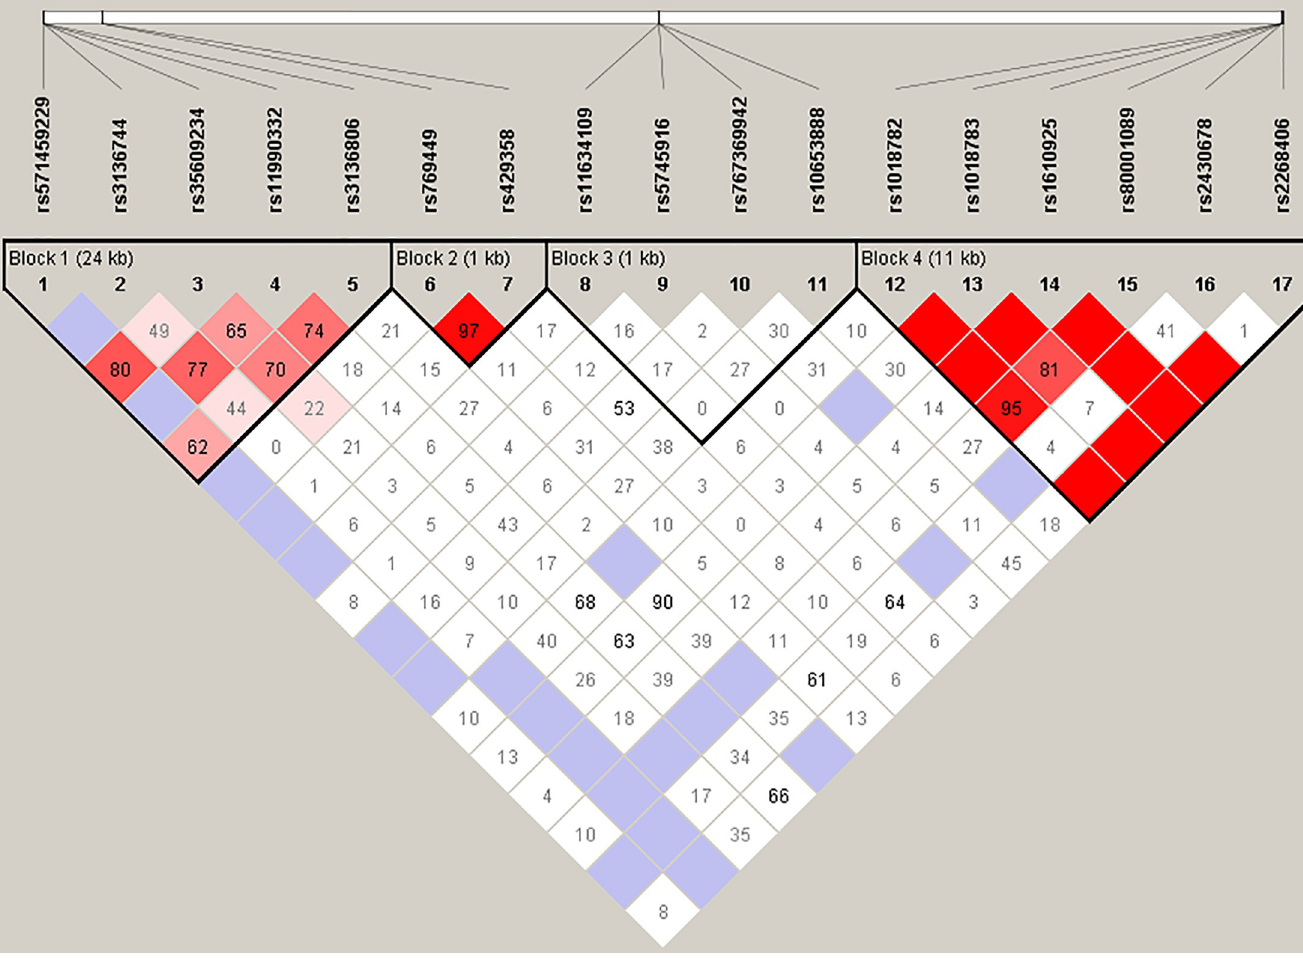
Fig 3. Linkage disequilibrium plot of all studied LOAD blood gene variants. D’ (pairwise SNP correlation) values were represented in the boxes. The plot’s block 1, 2, 3 and 4 were defined according to the genes in the following order; POL β , APOE , NEIL1 and UNG .